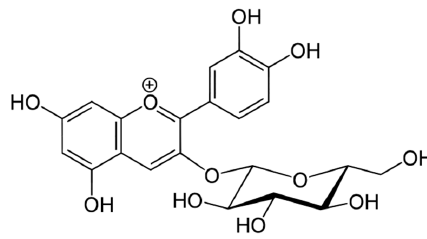
Figure 4. Cyanidin-3-glucoside.